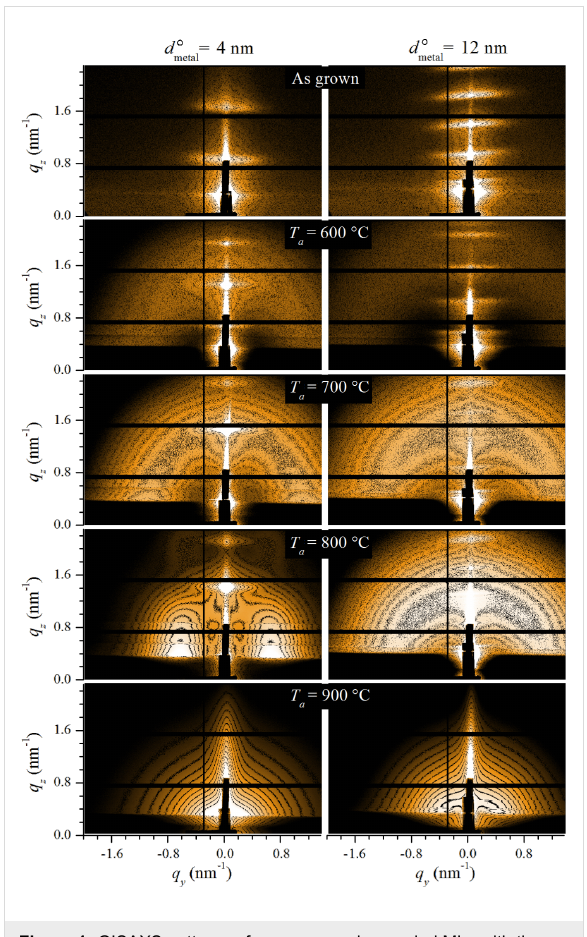
Figure 1: GISAXS patterns of as-grown and annealed MLs with the thinner (left column) and thicker (right column) metallic layers. The vertical and horizontal black lines are non-counting gaps between the segments of the 2D